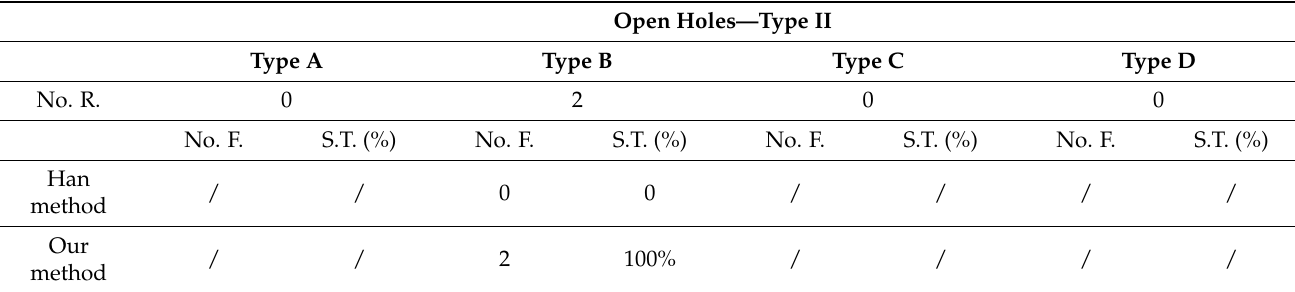
Table 2. Distribution and repair statistics of type II open